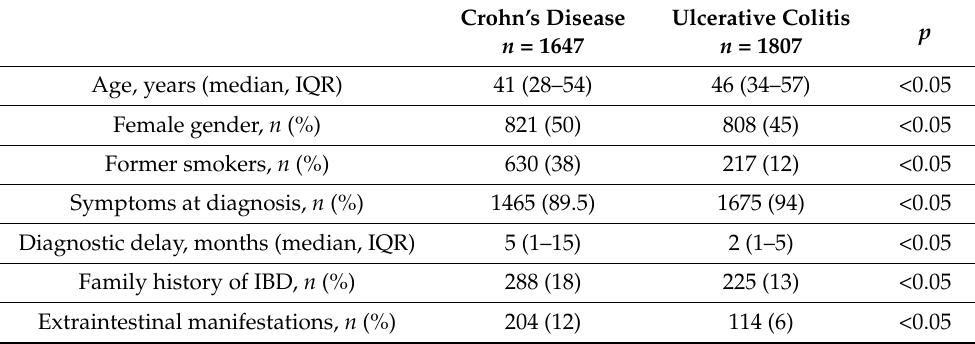
Table 2. Characteristics of the inception cohort based on inflammatory bowel disease type (Crohn’s disease vs. ulcerative colitis).